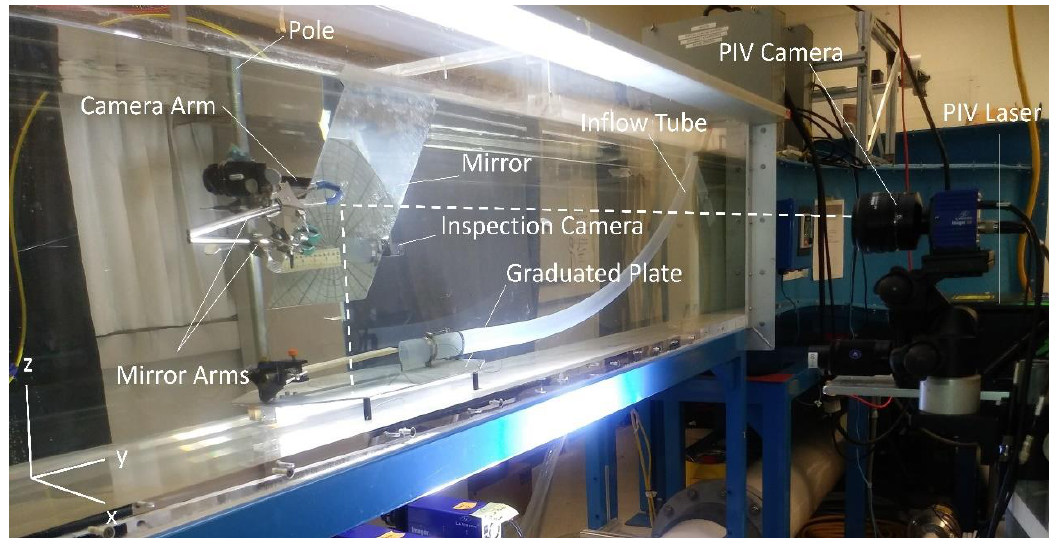
Figure 1. Calibration test setup at the Fluid Mechanics Laboratory, University of Victoria,